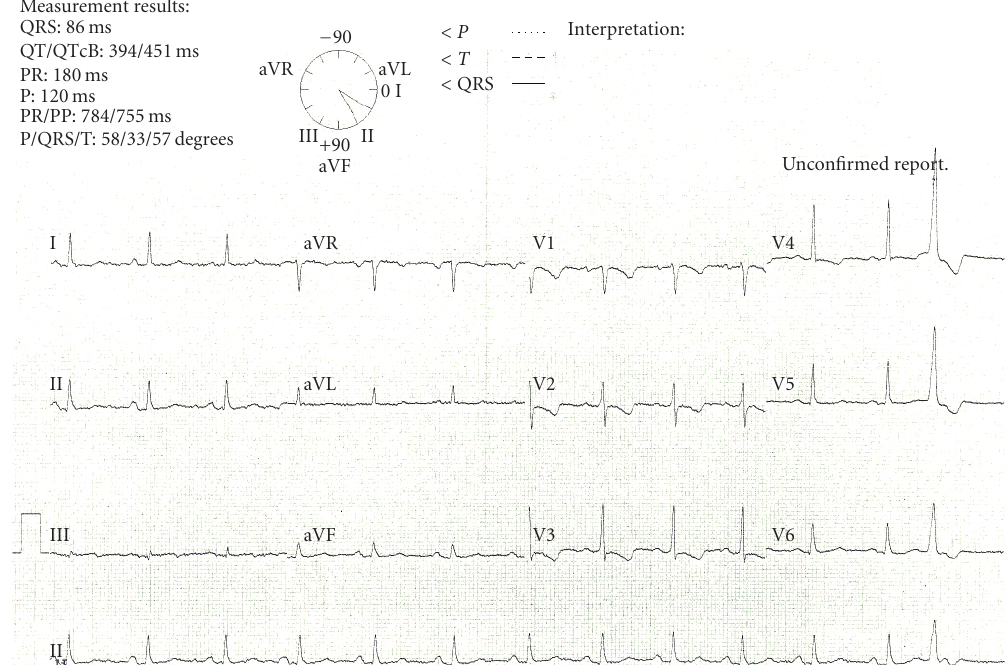
Figure 3: ECG immediately post angiography and IC